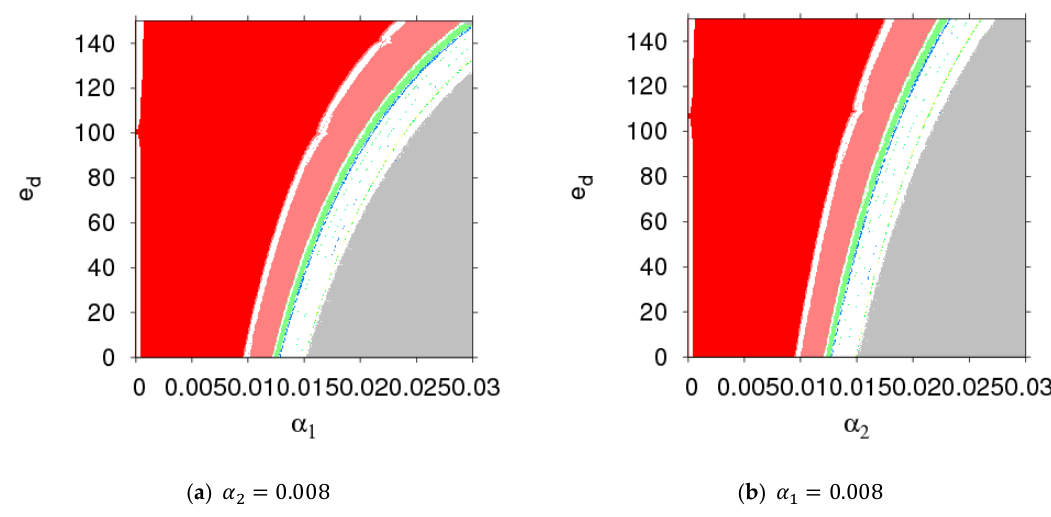
λ λ ) and ( α ) . 2 , 1 , 1 1